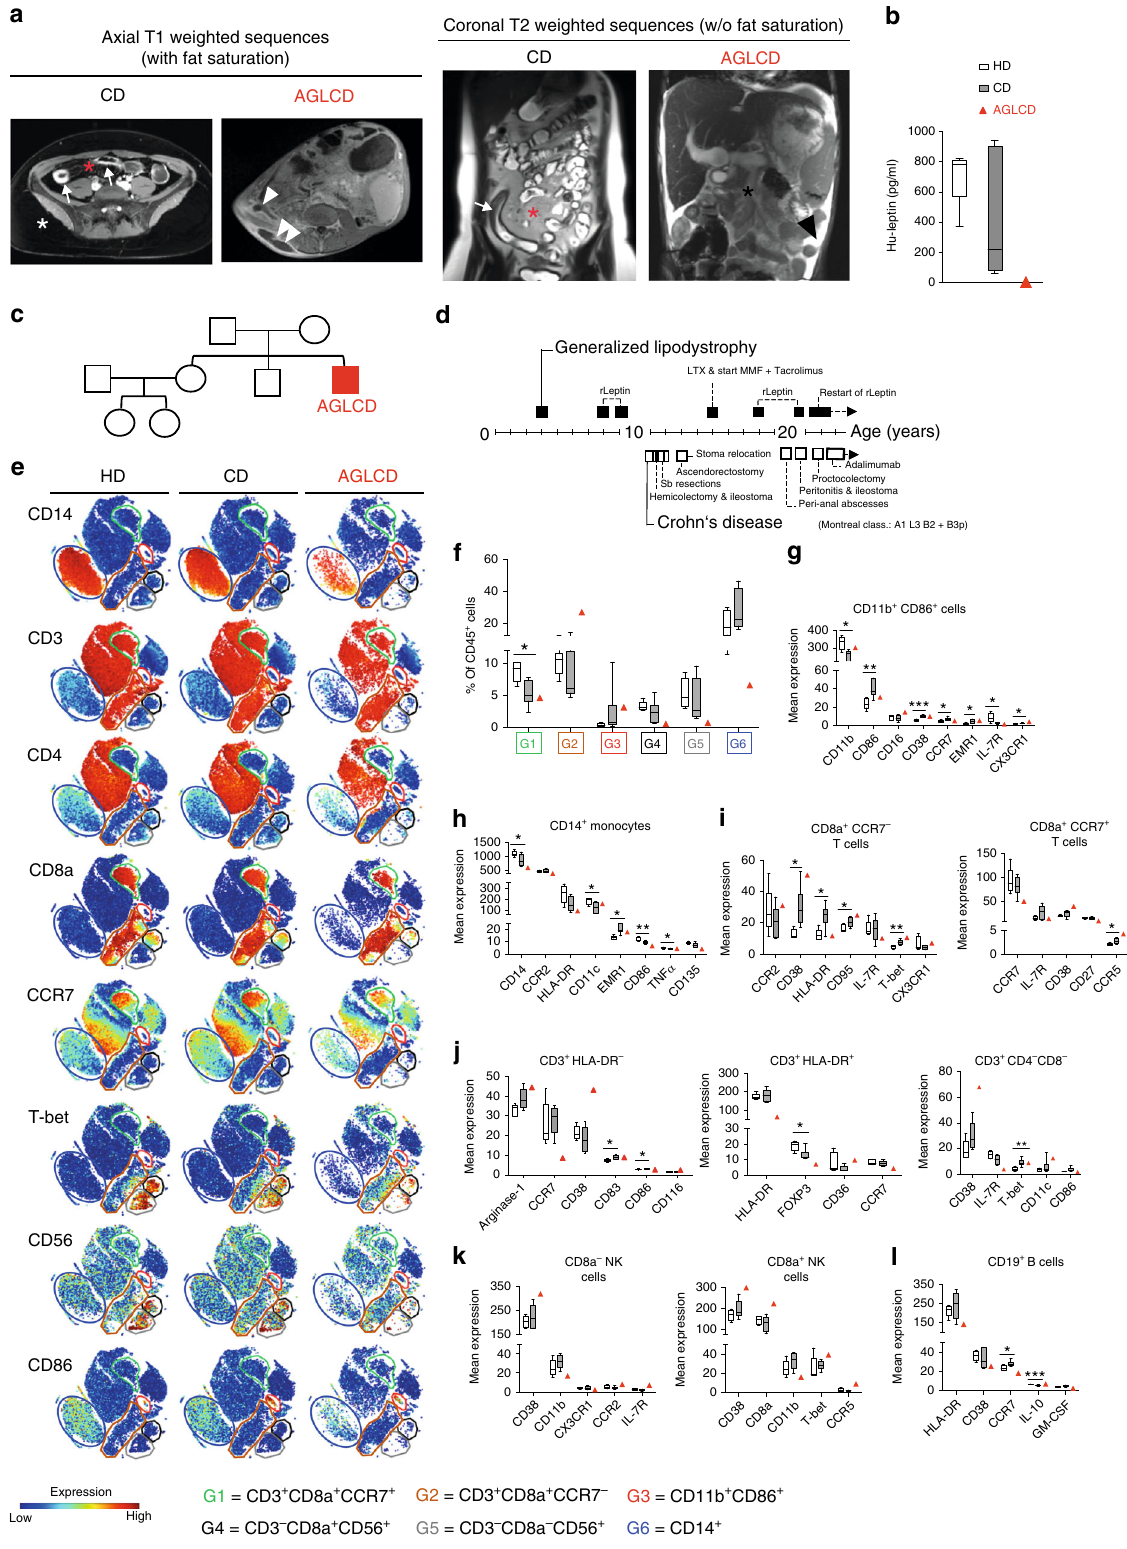
by comparable expression patterns of several differentiation and functional markers on CD11b + CD86 + cells and CD14 + monocytes of CD patients and the AGLCD patient (Fig. 1g, h). In contrast, we found a severe reduction of CD14 + monocytes (G6) and of Tbet + CD56 + CD8 + (G4) and Tbet + CD56 + CD8 − NATURE COMMUNICATIONS| (2019) 10:5629